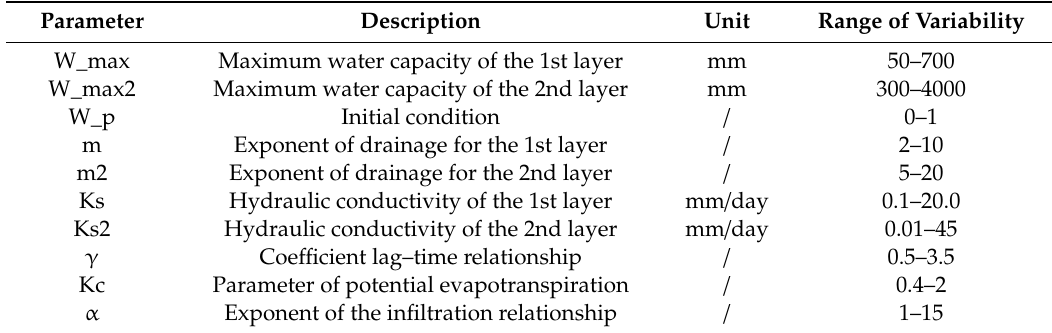
Table 3. Parameters of the MISDc-2L